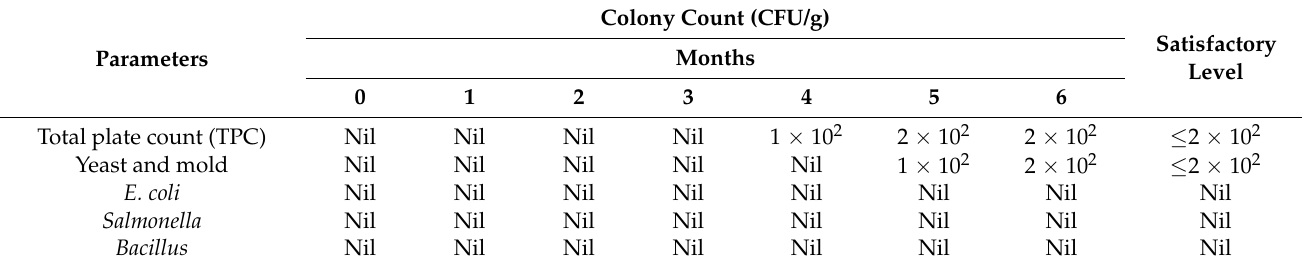
Table 3. Shelf-life of FTM50 noodles 1